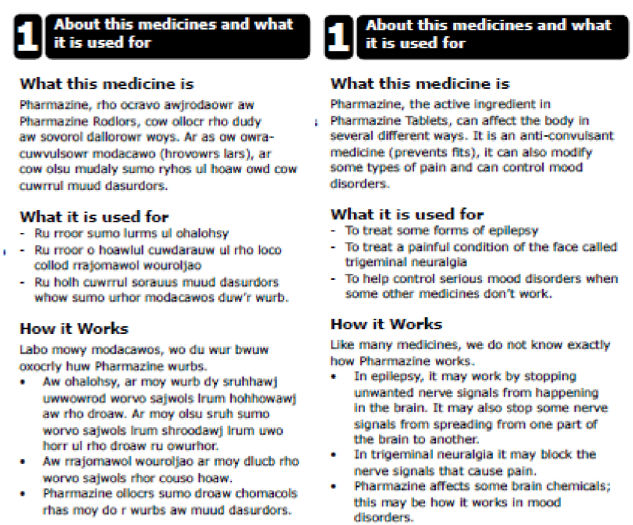
Fig 1. Bogus and Real text versions for the first section of the revised